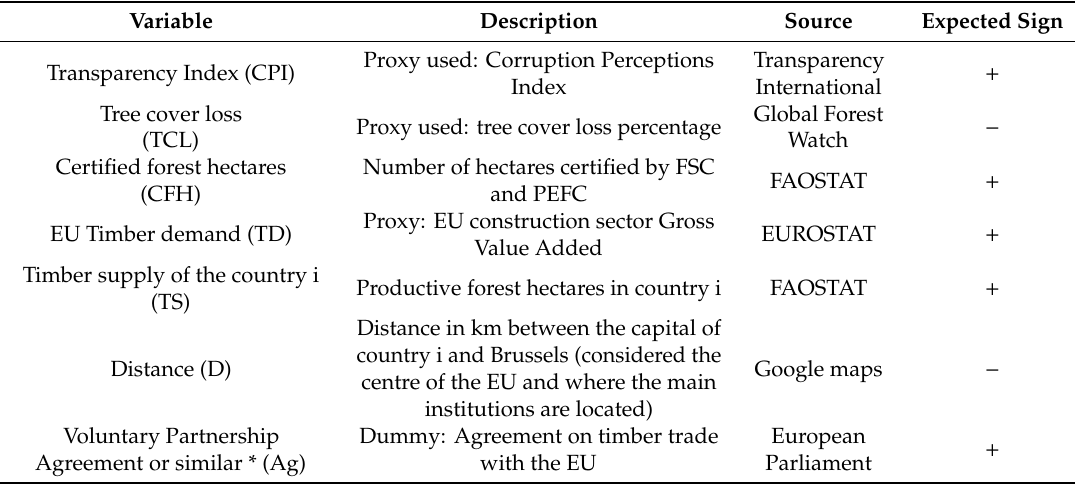
Table 1. Independent variables used in the analysis: description, sources and expected relationship with the dependent